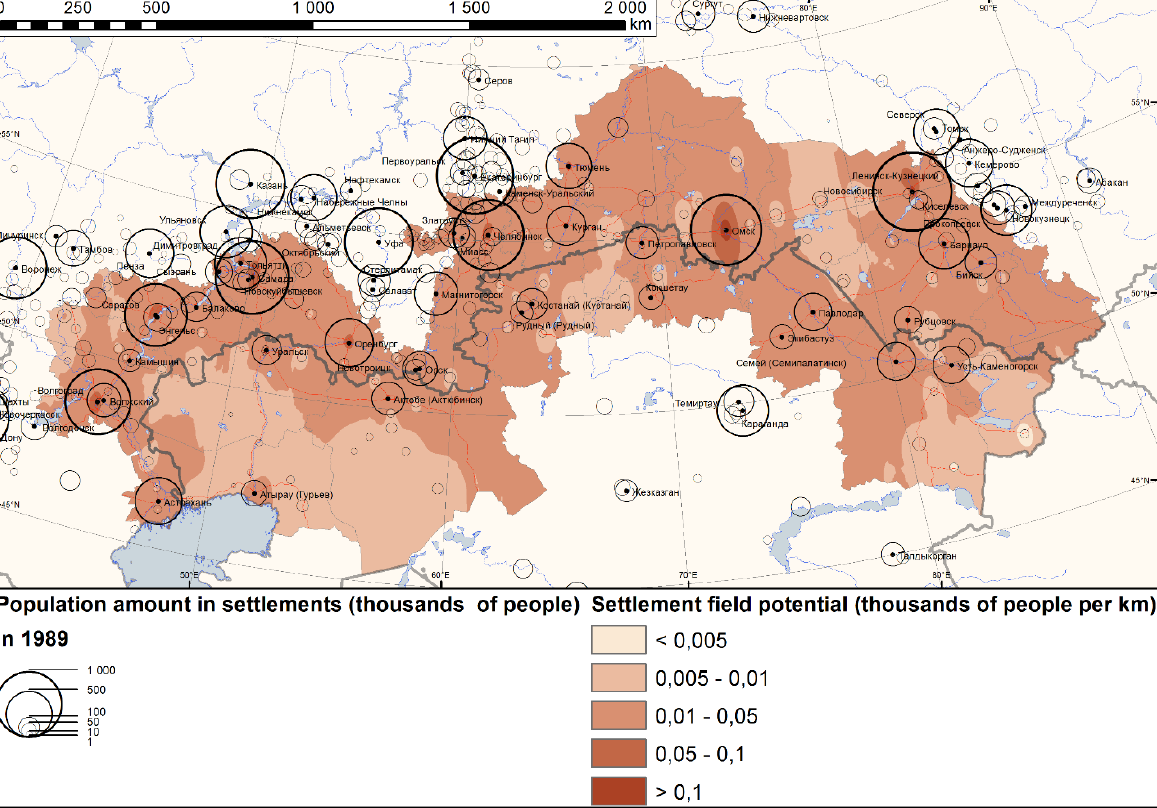
Figure 2 . Draft map visualization of the direct-distance-based settlement field potential for the Russia-Kazakhstan transborder region. WGS-84/Alberts conic projection. Inverse distance weighting interpolation was used for spatial interpolation of settlement field